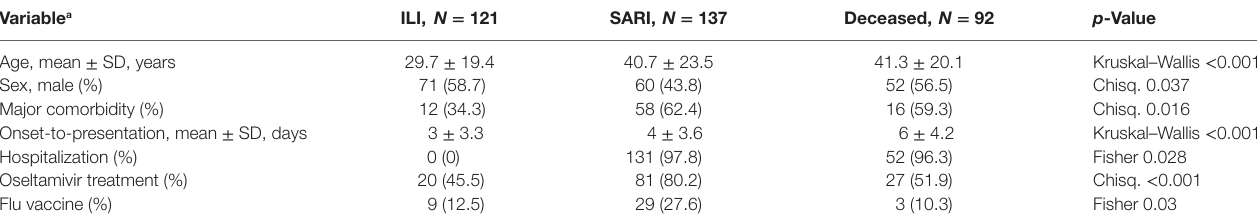
TaBle 2 | Descriptive data of clinical characteristics of H1N1-infected patients enrolled in the study of genetic association of PIK3CG polymorphisms. Variable a